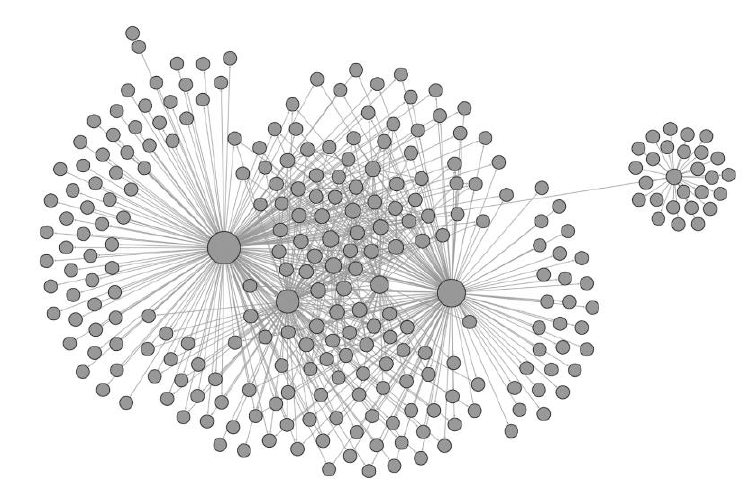
Figure 3. The connected components of the social network for the control group. Nodes represent participants, and edges represent connections (followers). The size of each node is proportional to the degree (number of connections).